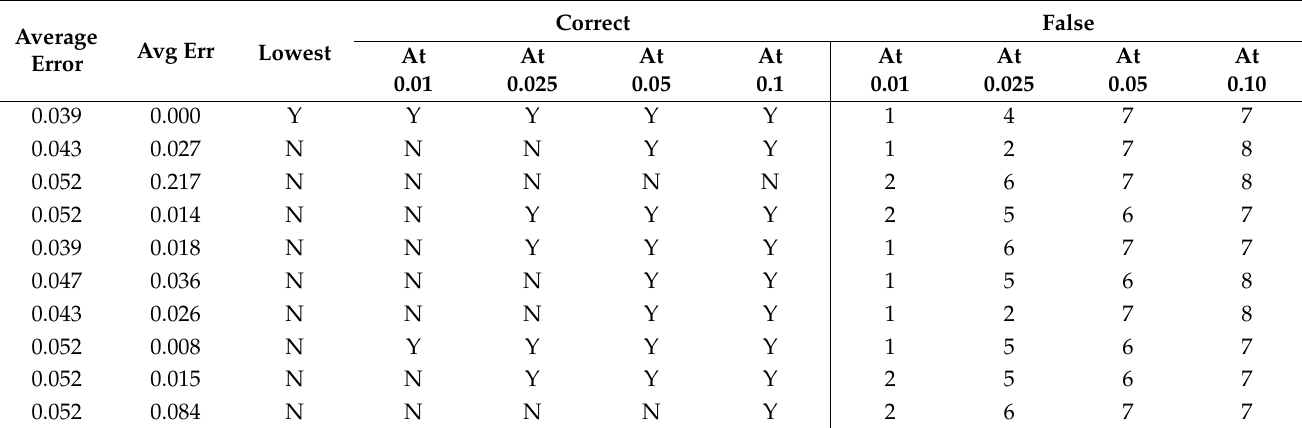
Table A15. Set 1, trials 1–10 summary data (all 0.5 PR values).